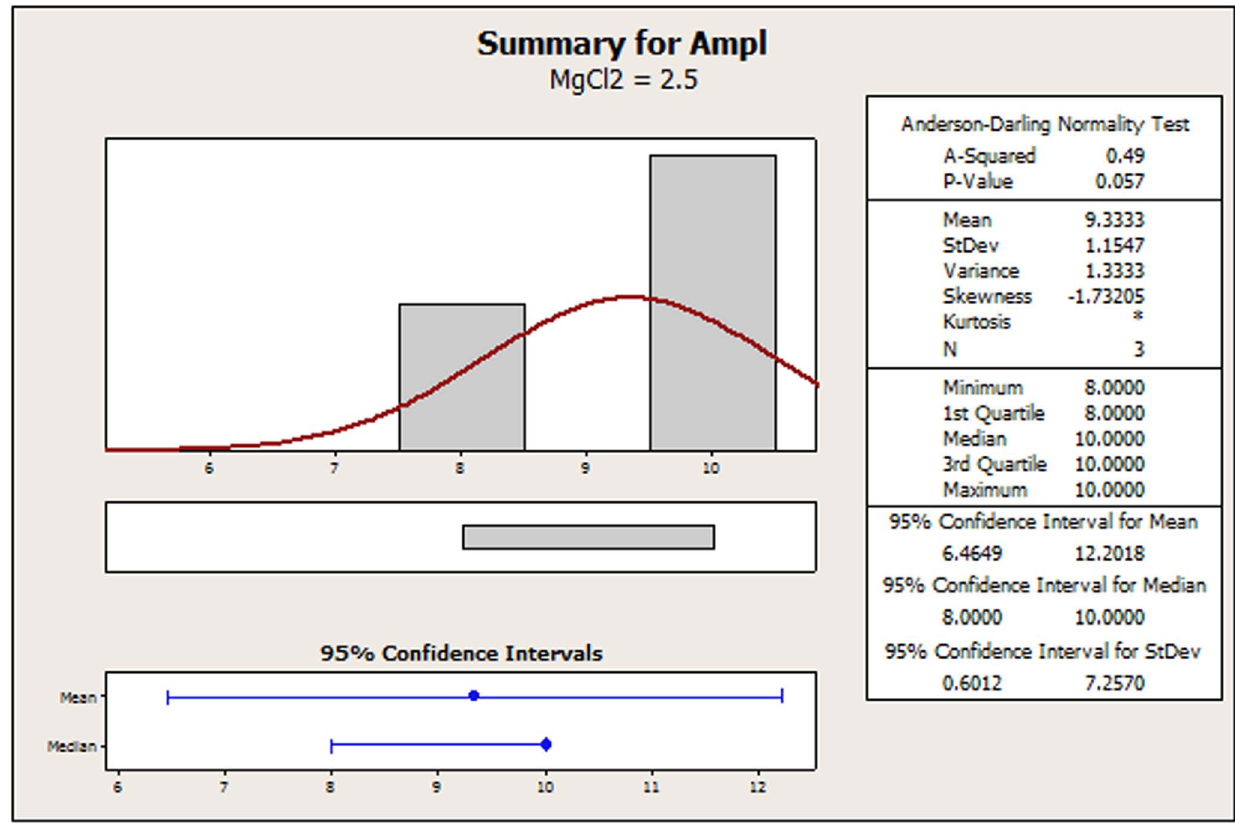
Figure 2. Summary statistics of amplicon performance for MgCl 2 concentration at 2.5 mM.